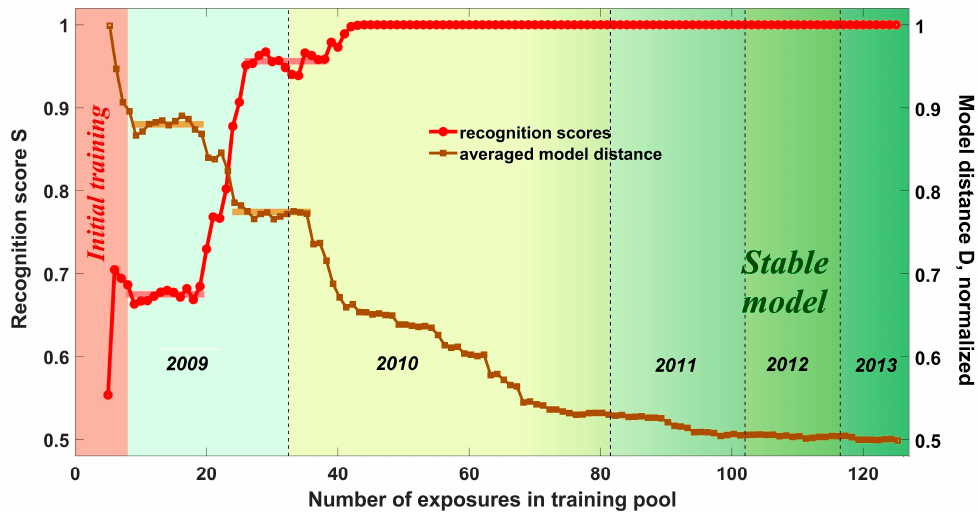
Figure 13. Evolution of S TRM ( N ) and the characteristic distance of the analyte-related clusters in the LDA space, D , with increasing the number N of e-nose exposures included into the training pool. The data of e-nose exposures to odors of pen and lighter have been recorded between April 2009 and September 2013. The distance D is normalized by the value observed at the initial e-nose training.